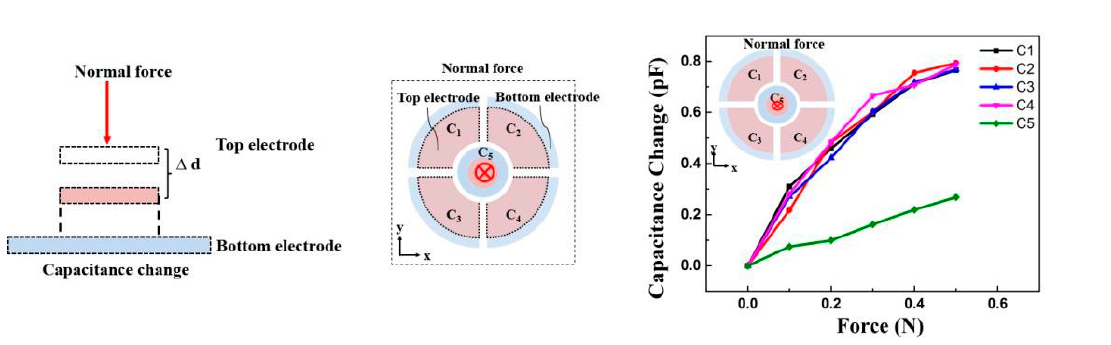
Figure 4. Schematic of ( a ) the sensing mechanism in normal force ( b ) the measured capacitance changes for the normal force in –z-direction.